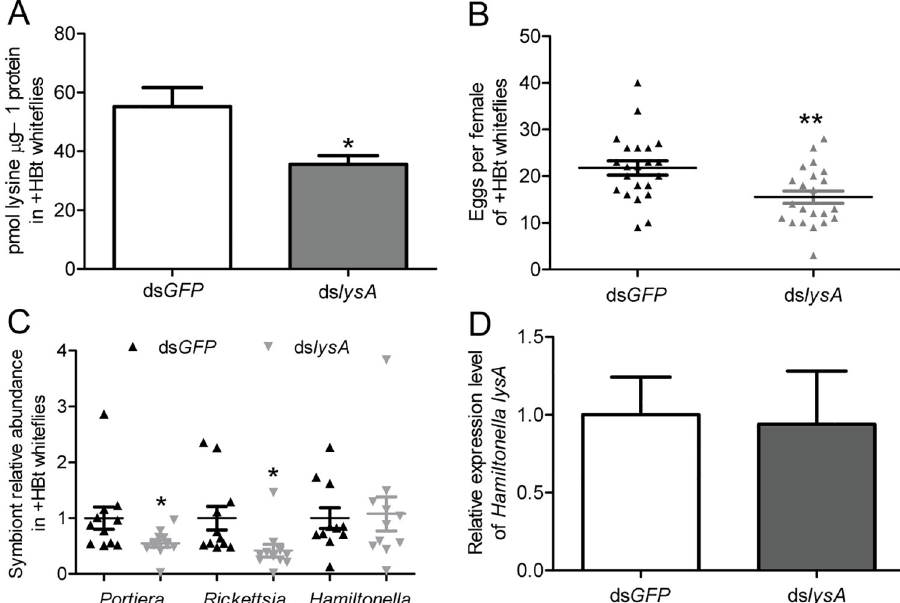
Fig 5. Effects of silencing horizontally transferred lysA on lysine levels, whitefly fecundity, symbiont titer and Hamiltonella lysA expression in whiteflies infected with Hamiltonella . (A) Lysine levels in whiteflies at day 3 after whiteflies were microinjected with ds lysA . n = 3. (B) Fecundity of female adult whiteflies at day 3 after microinjection with ds lysA . n = 22. (C) Effects of silencing horizontally transferred lysA on symbiont titer. n = 11. (D) Expression of Hamiltonella lysA at day 3 after whiteflies were microinjected with ds lysA . n = 4. ds GFP and ds lysA represent ds GFP - injected and ds lysA -injected female adult whiteflies, respectively. Data are means ± SEM. The significant differences between treatments are indicated by asterisks ( � P < 0.05; �� P <